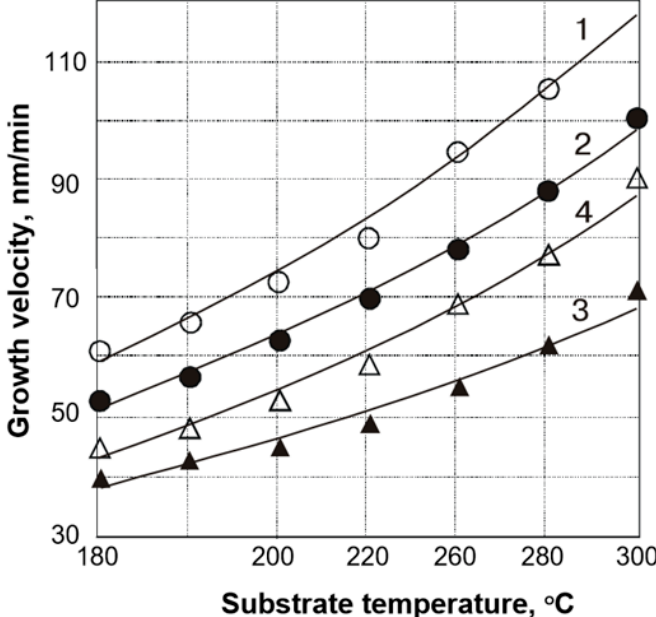
Figure 11. Dependence of MOCVD growth velocity of SmS for different substrate temperatures and the used precursors: 1, dtc3Sm bipy; 2, dtc3Sm phen; 3, dtc3Sm (without water ambient); and 4, dtc3Sm (with water ambient). (Reprinted with permission from [65].)